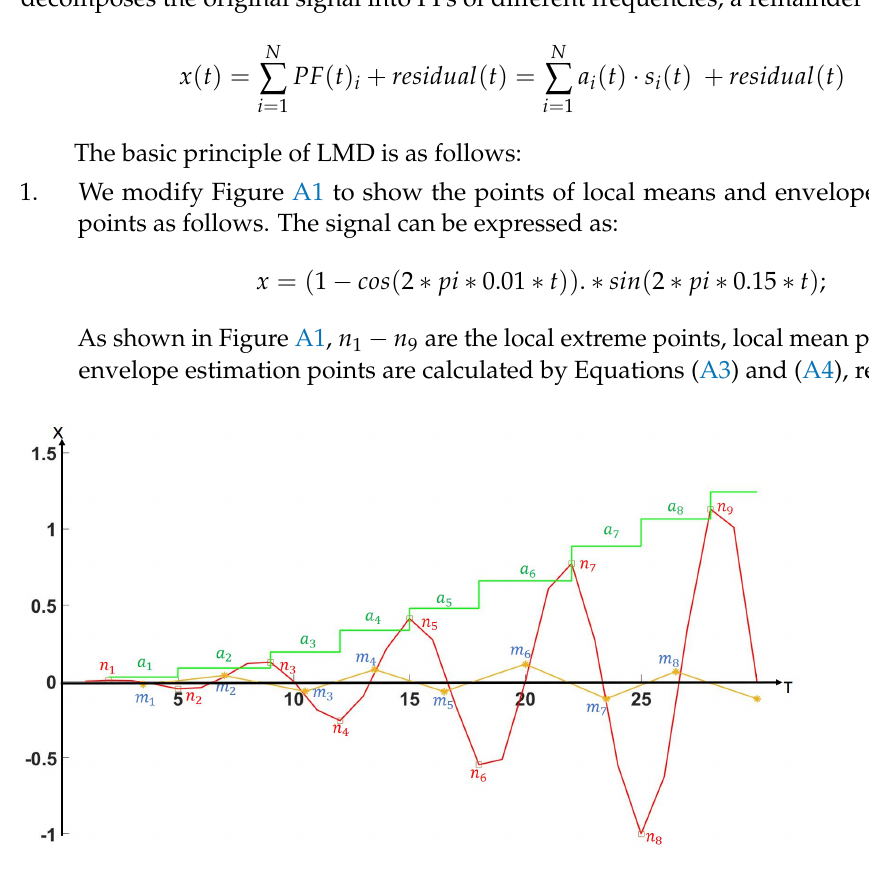
Figure A1. points of local means ( m i ) and envelope estimation point ( a i